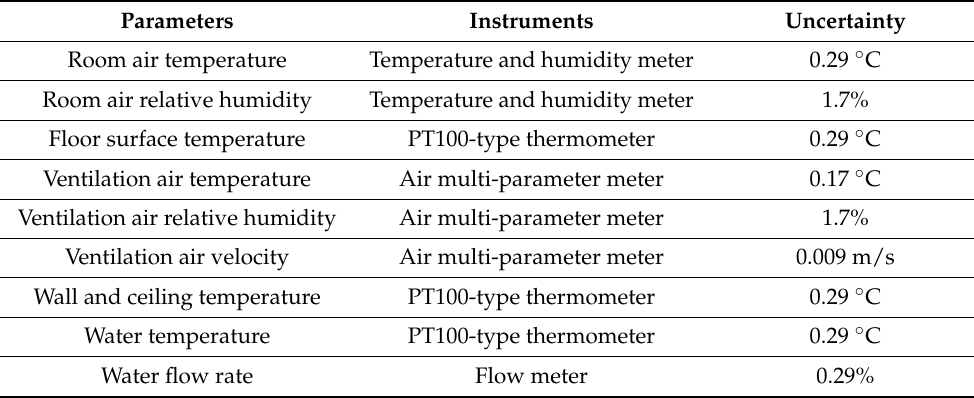
Table 4. Accuracy and uncertainty of measured